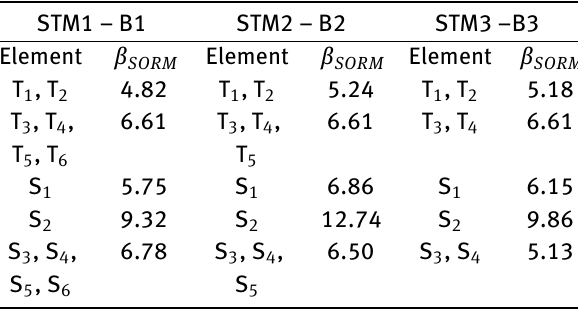
Table 2: Reliability index of individual members in the reliability structures of the analysed beams